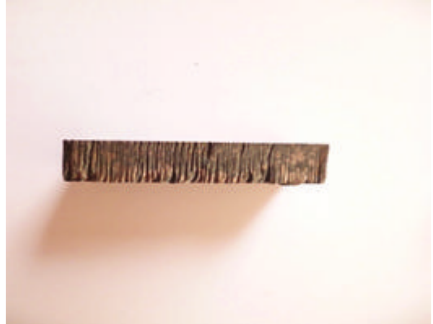
Figure 1: Low carbon steel plate carved by CO 2 laser.